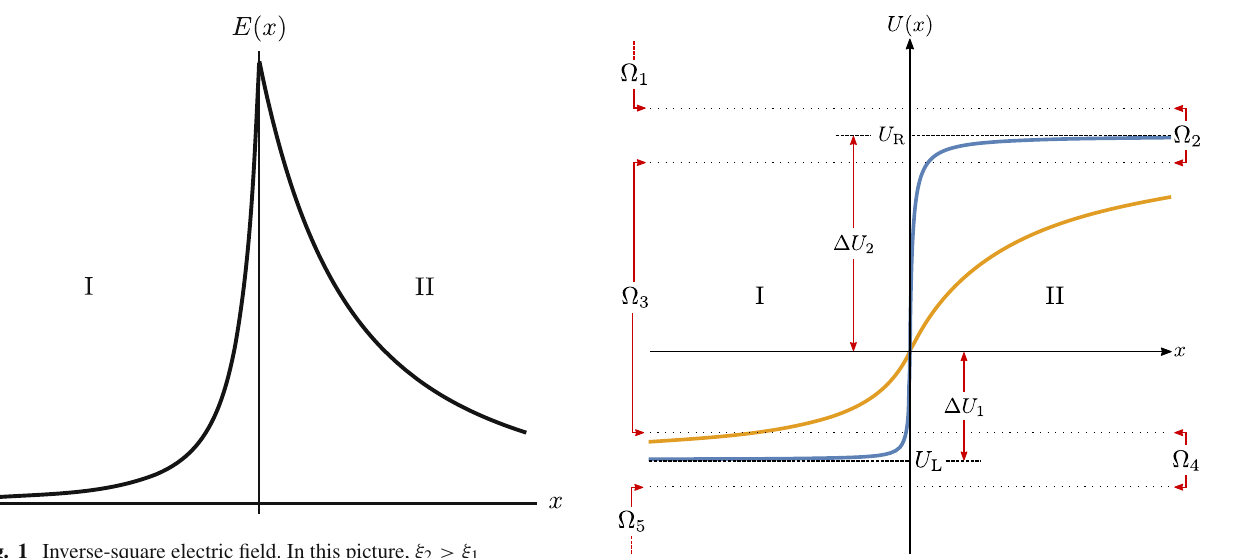
Fig. 1 Inverse-square electric field. In this picture, ξ 2 > ξ 1 we represent an asymmetrical inverse-square electric field, in which ξ 2 > ξ 1 .